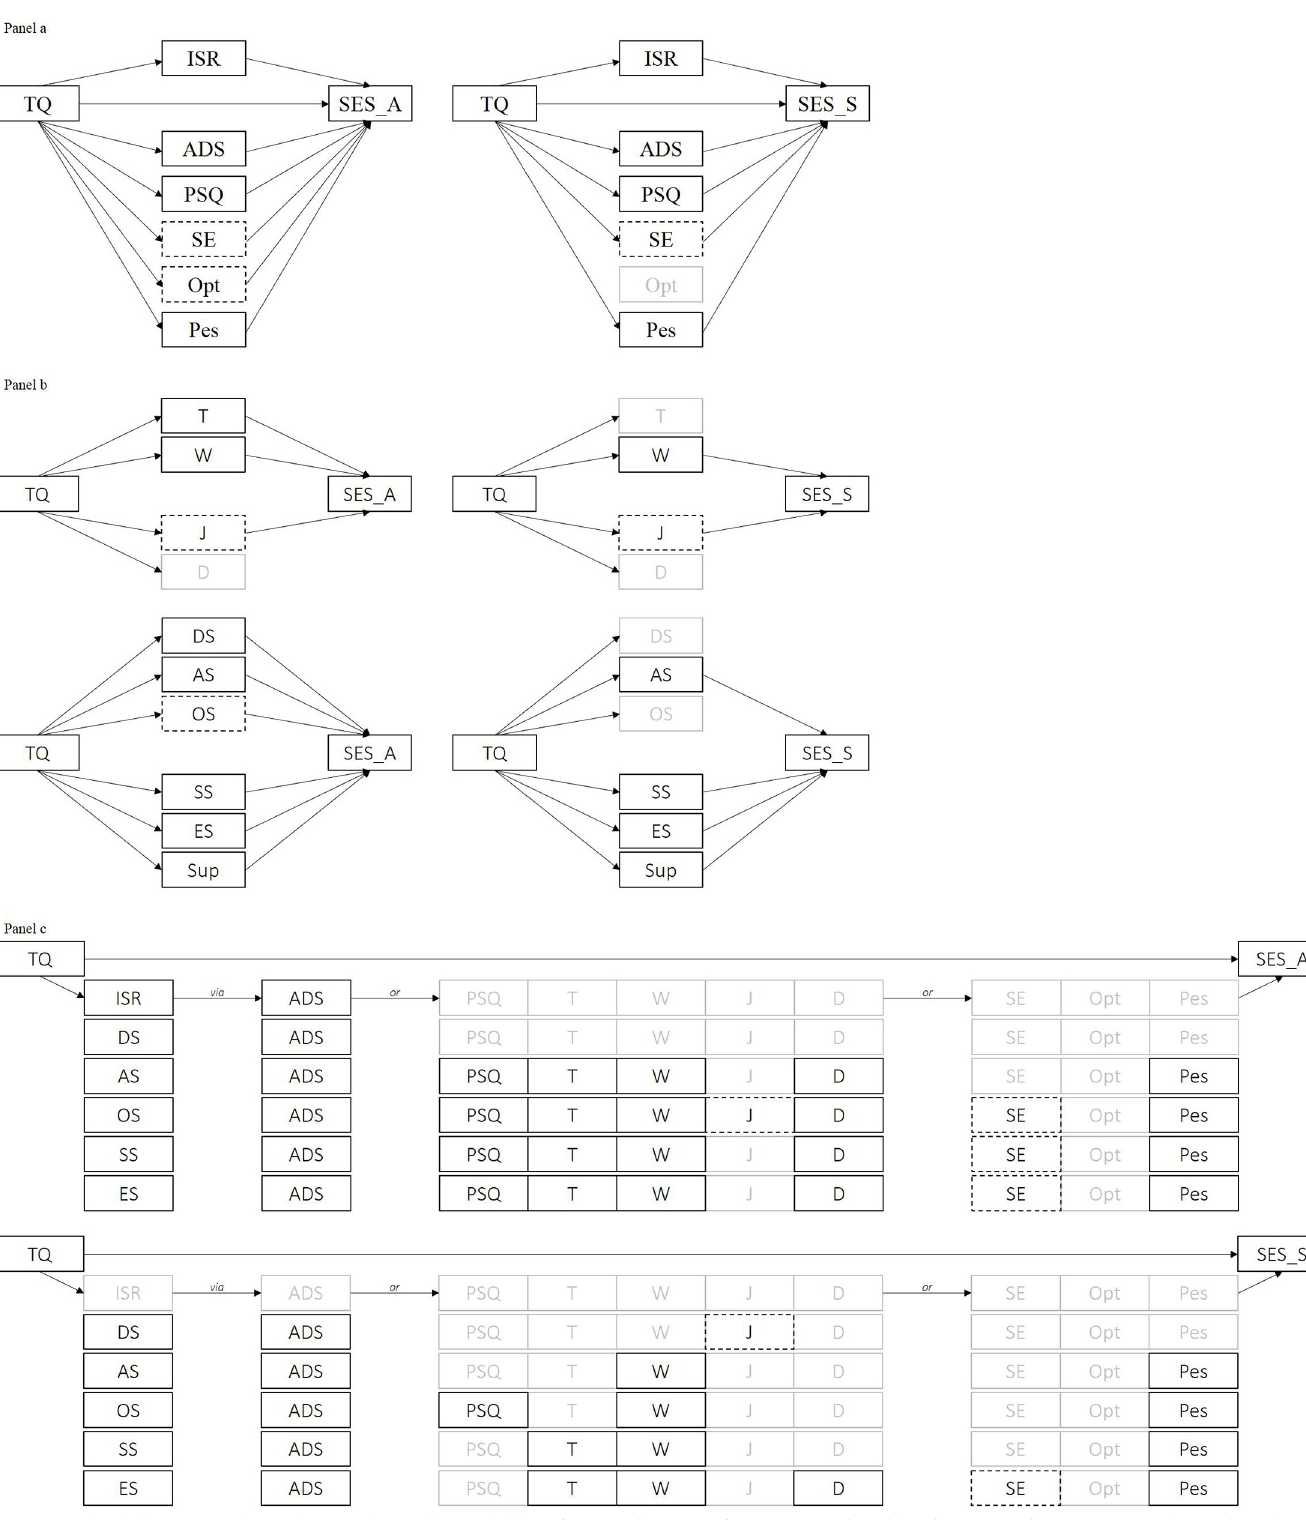
Fig 2. Graphical illustration of significant indirect effects. Black box frames indicate significant positive, dotted box frames significant negative and greyed-out boxes non-significant indirect effects. Panel a : Results of the simple mediator models for affective (left) or sensory pain perception (right). Panel b : Results of the parallel multiple mediator models for PSQ- (upper row) and ISR subscales (lower row) mediating affective (left) or sensory pain perception (right). Panel c : Results of the serial